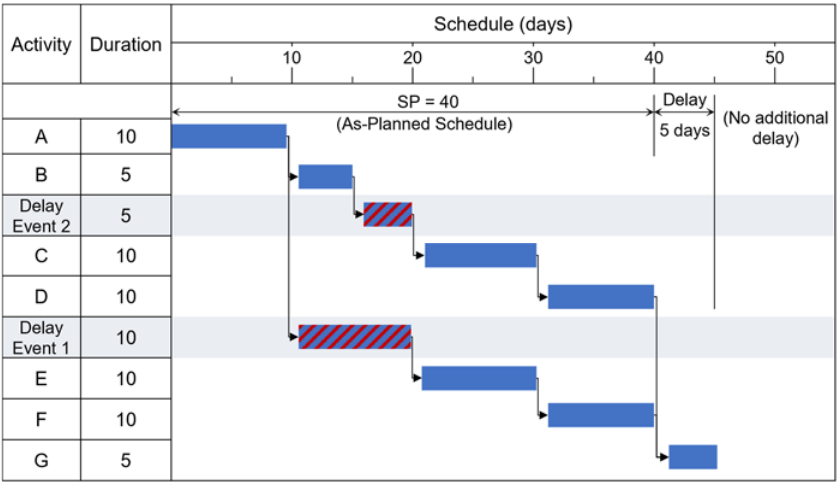
Figure 7. Impact of delay events 1 and 2.